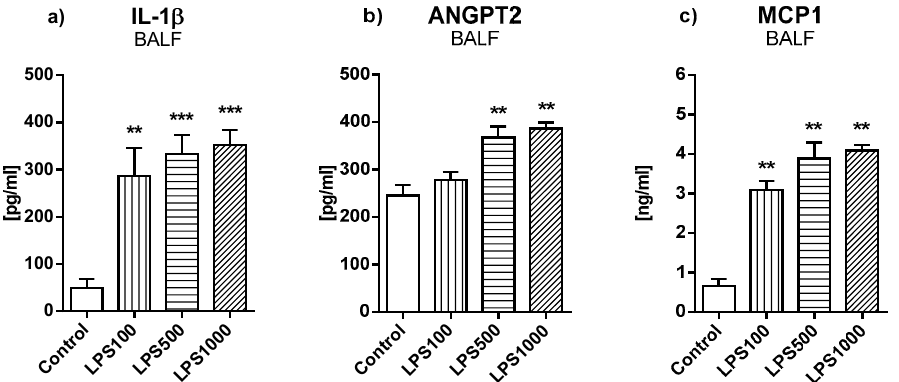
Figure 1. Lung edema formation at the end of the experiment. Values represent the W / D (wet / dry) weight ratio of lung tissue. Control vs. LPS-treated groups ** p < 0.01, *** p < 0.001.